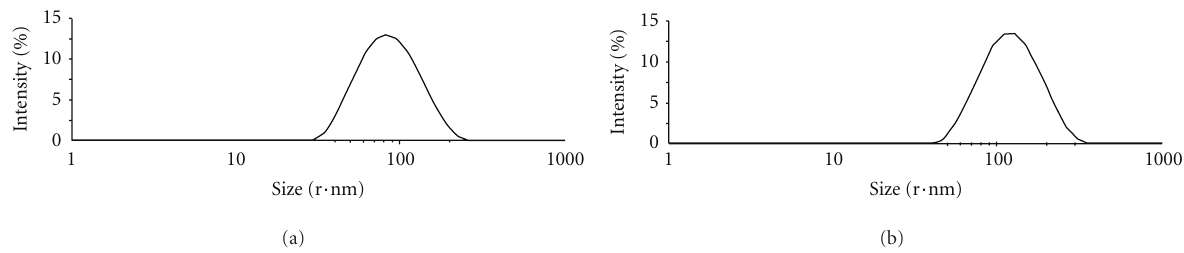
Figure 1: Particle size distribution of tacrolimus liposomes (a) and ethosomes (b) by dynamic laser light scattering.